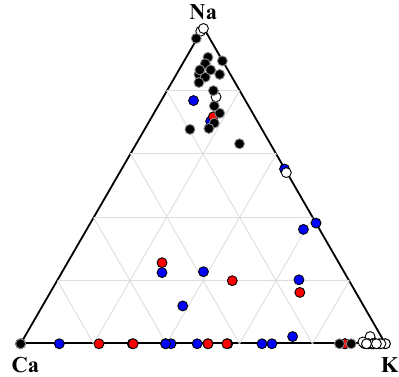
Figure 7. Ternary diagram of Na–Ca–K components, showing the compositions of mineral dust particles identified by SEM-EDX analysis. Data are presented in relative atomic proportions. The circles indicate non-active particles (red) and IN active particles (blue). Particles of Na-feldspar (black) and K-feldspar (white) are also shown for